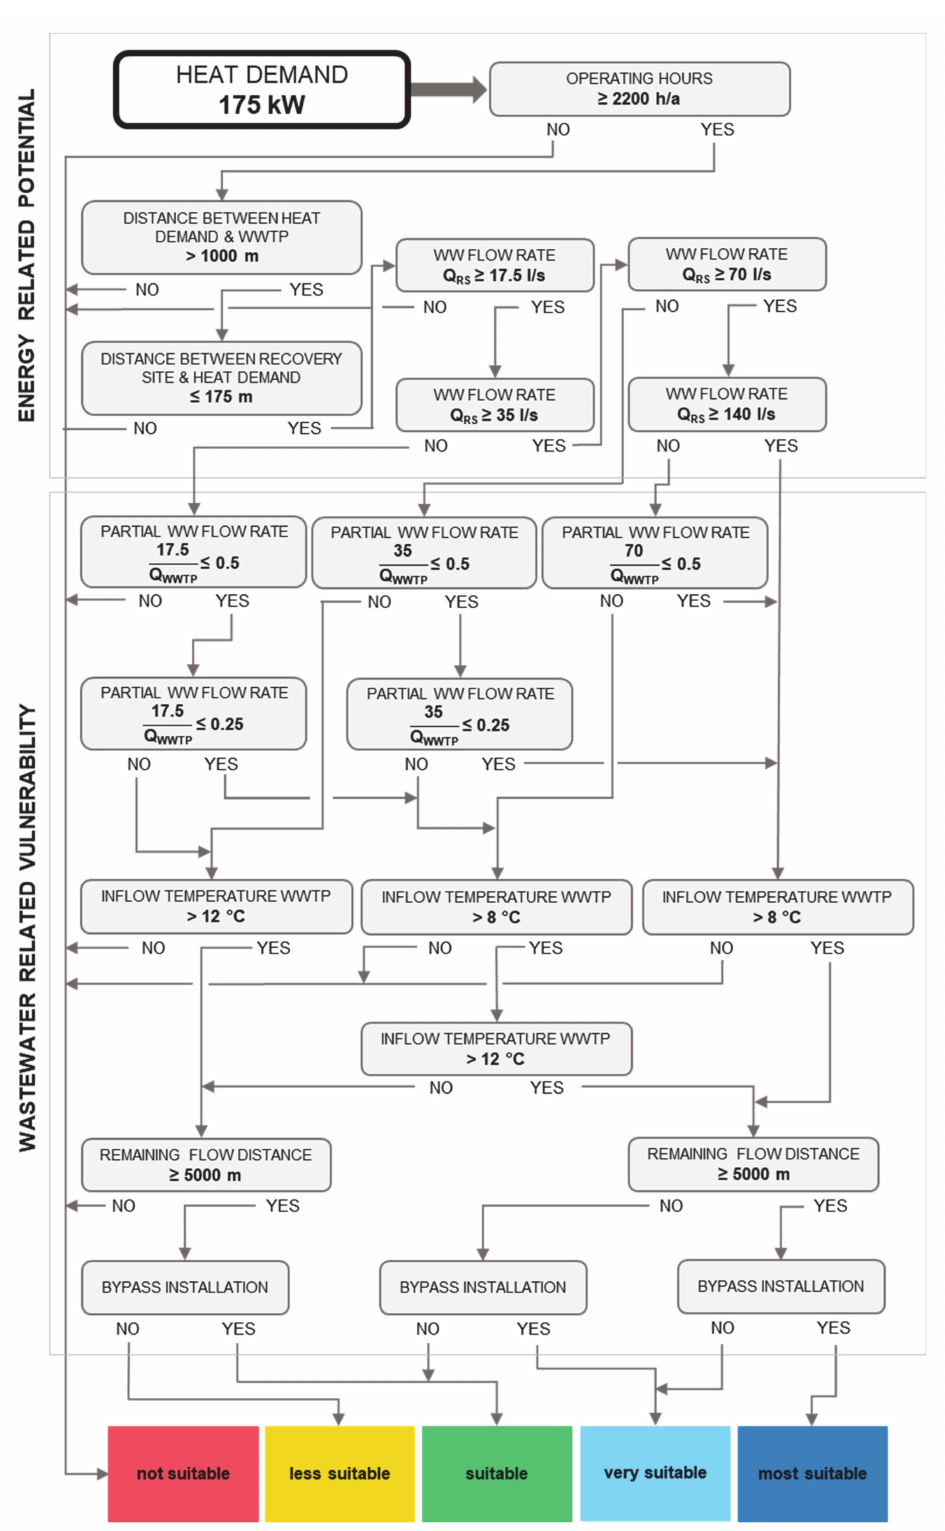
Figure A4. Relevance tree for an intended heat supply of 175 kW (own representation, based on